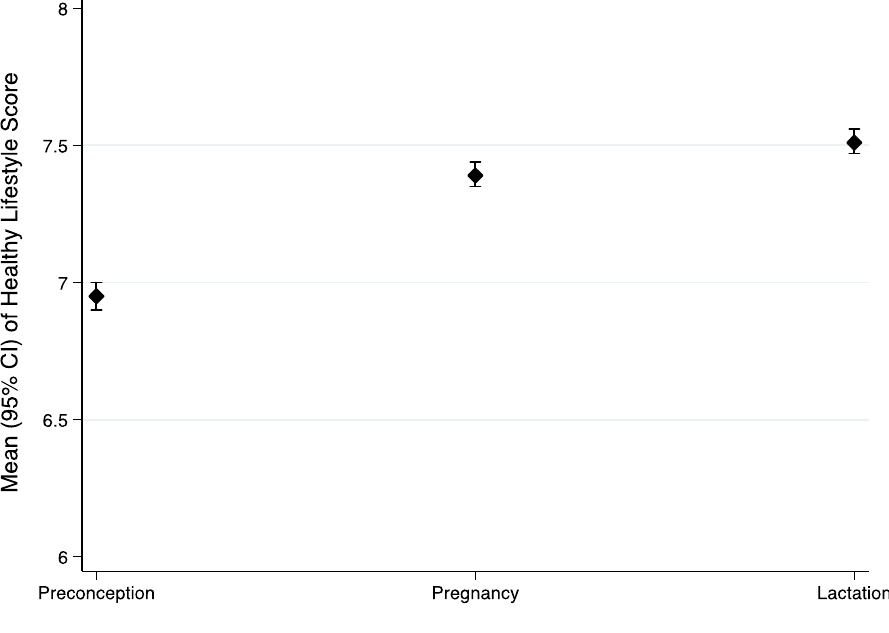
Table 4. Proportion of total variability in the healthy lifestyle score ( R 2 ) explained by individual